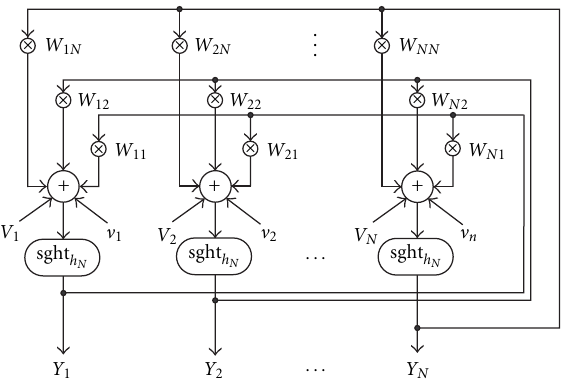
Figure 3: The structure of the modified recurrent neural